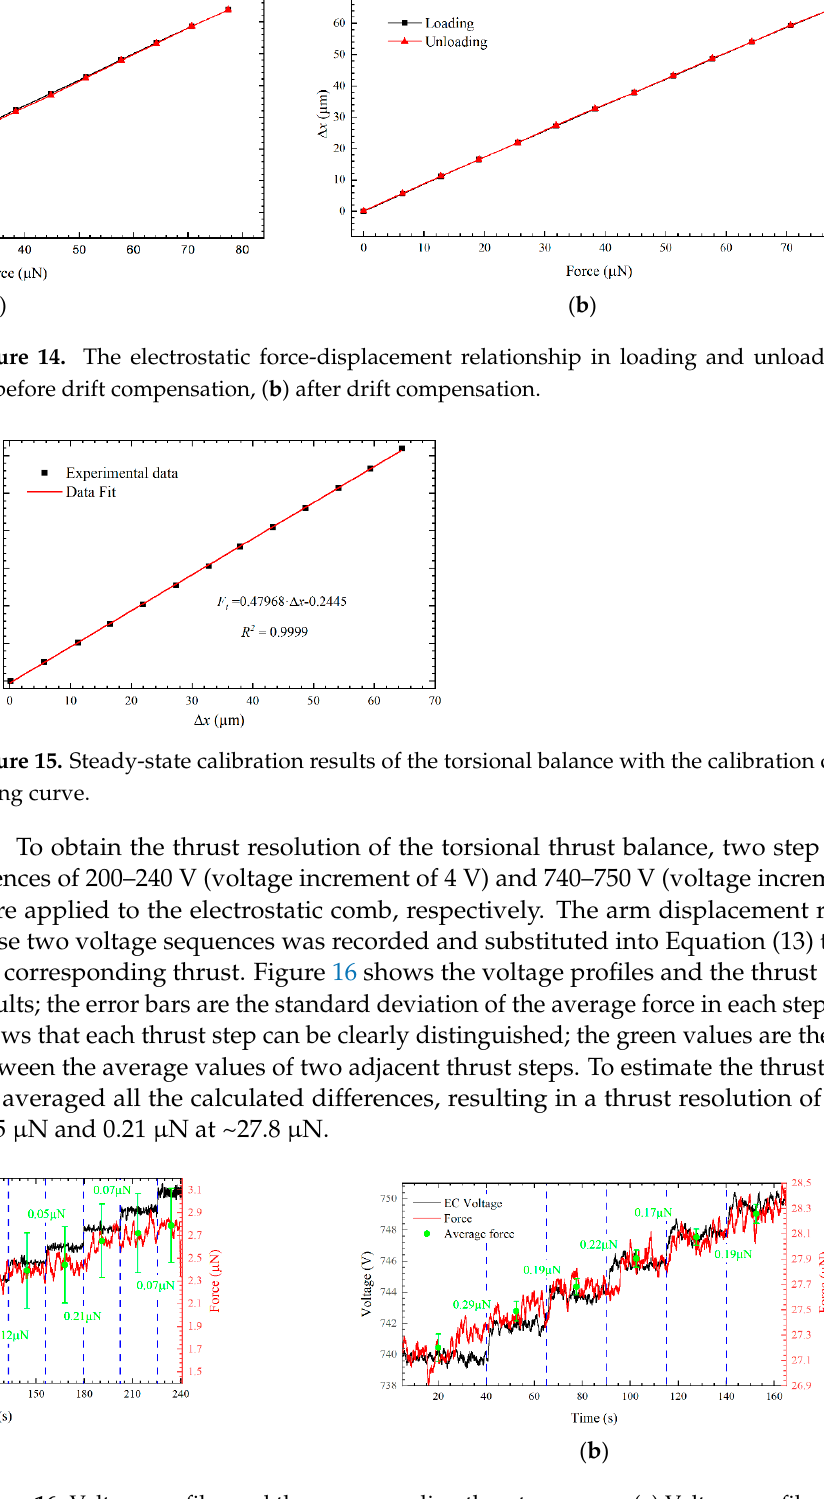
Figure 16. Voltage profiles and the corresponding thrust response. ( a ) Voltage profile of 200–240 V, ( b ) voltage profile of 740–750